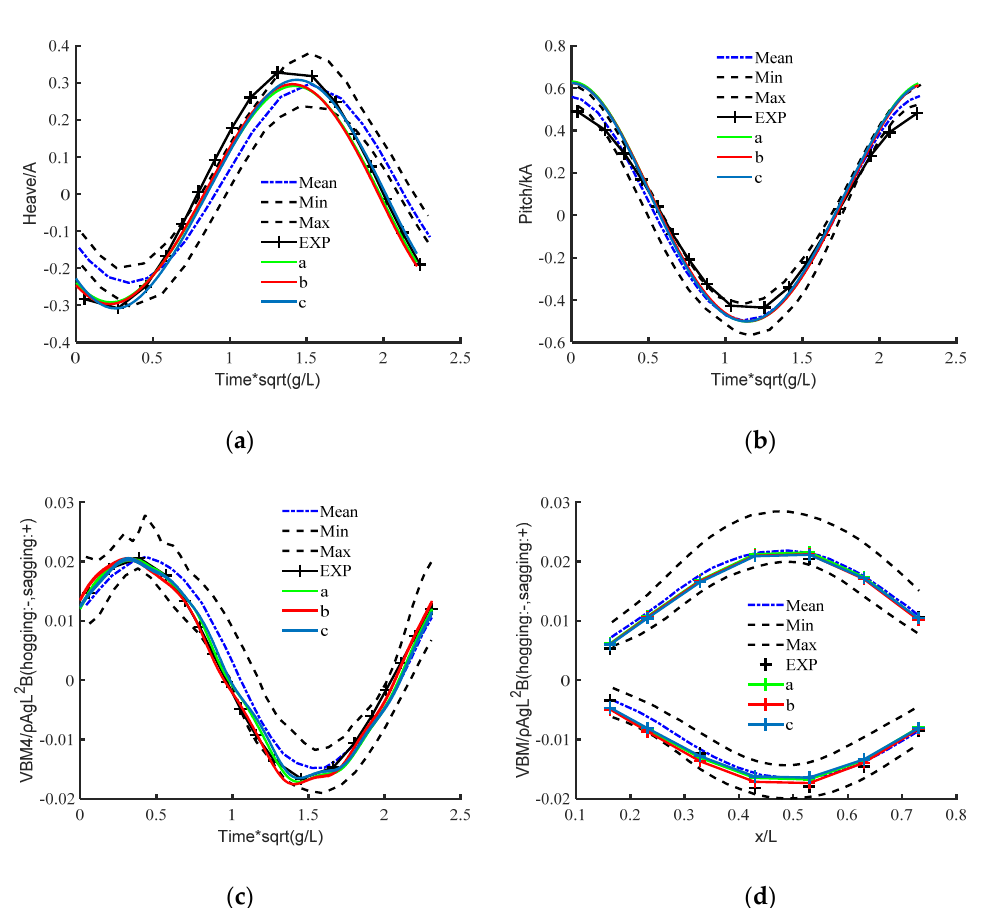
Figure 7. Comparison of the results between current model and other numerical/experimental results. ( a ) Heave; ( b ) Pitch; ( c ) Non-dimensional vertical bending moment at midship; ( d ) Non-dimensional vertical bending moment along the ship length.